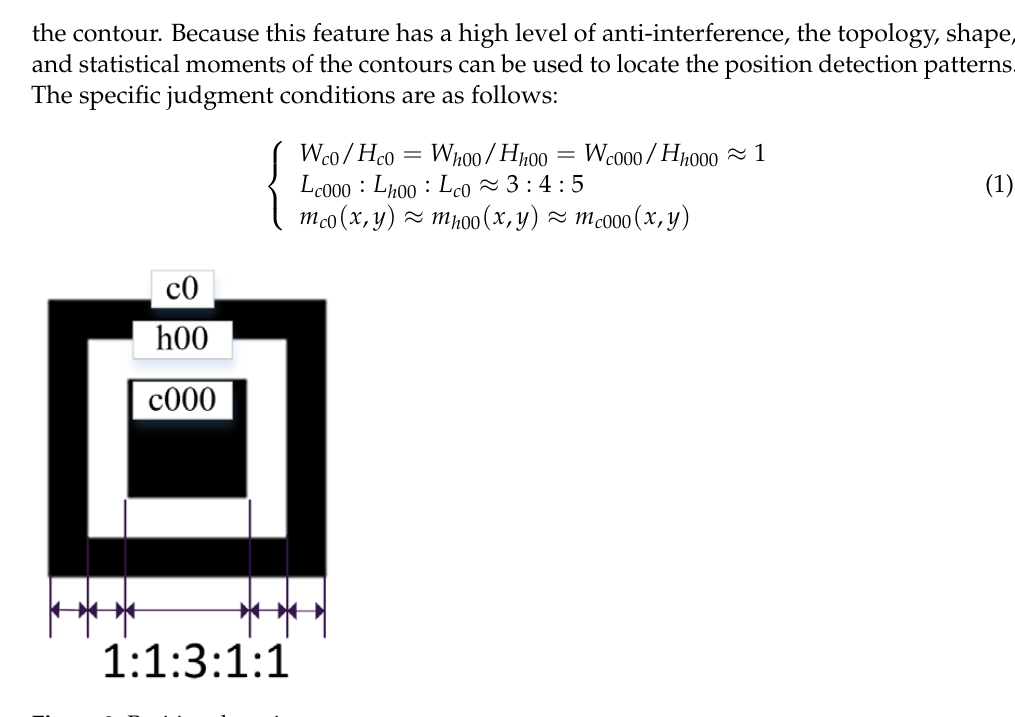
code’s four vertices. The center point coordinates m 1 of position 1 and m 2 of position 2 are used to calculate the equation of the line l m the center point coordinates m 0 of position 0 on l m which is